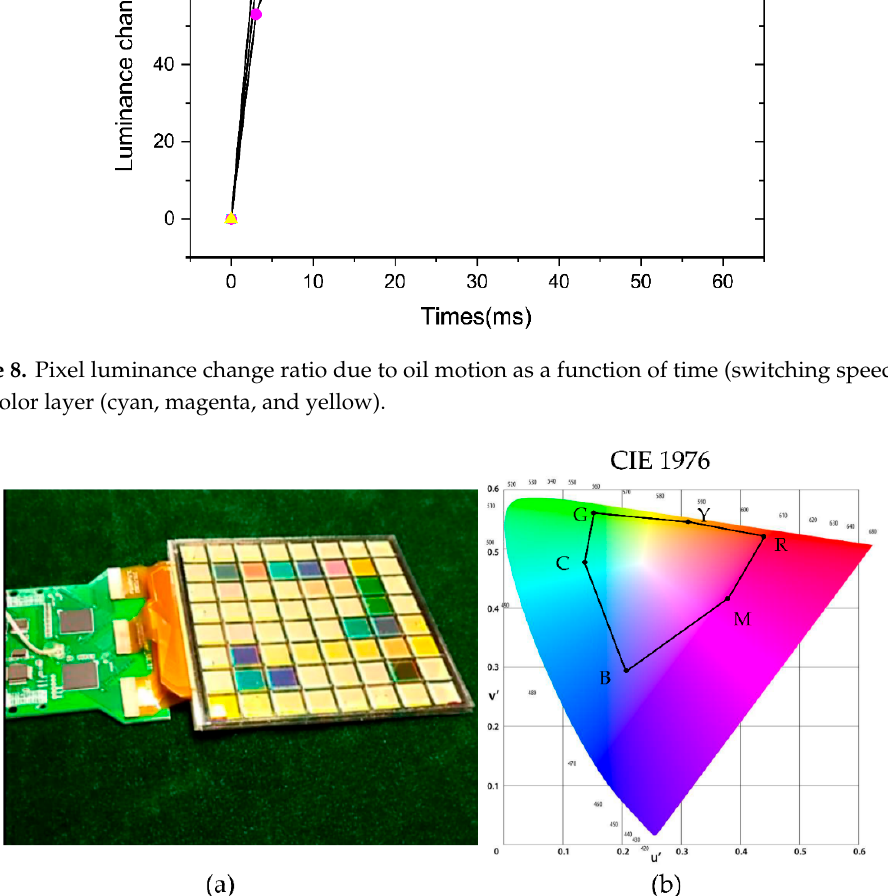
Figure 8. Pixel luminance change ratio due to oil motion as a function of time (switching speed) for each color layer (cyan, magenta, and yellow).